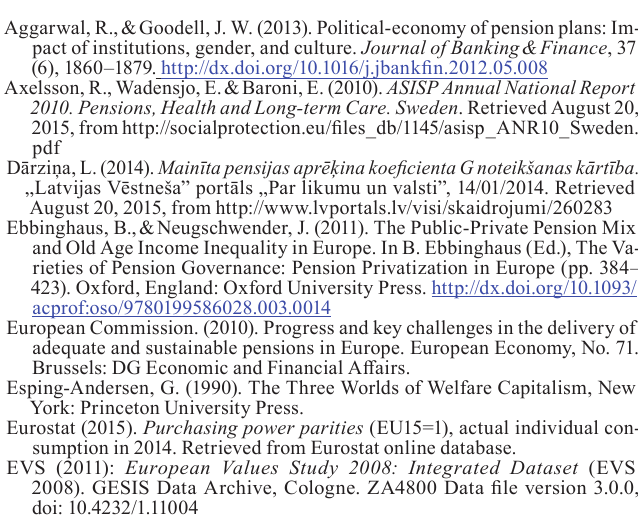
Fig. 3. Theoretical trajectories of notional capital valorisation depending on methodology of